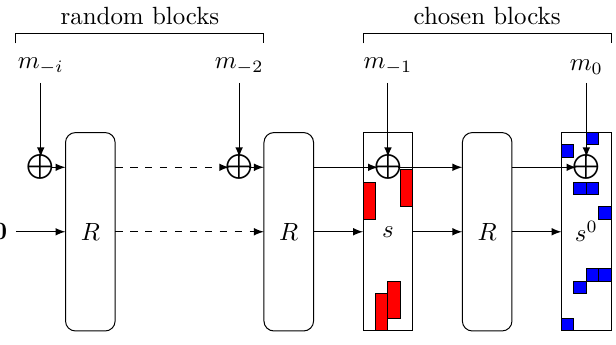
Figure 2: Finding state collisions in unkeyed absorbing. The m i ’s are 9-bit padded input blocks and we aim for a collision on s 0 . We tolerate a difference in s 0 the blue positions